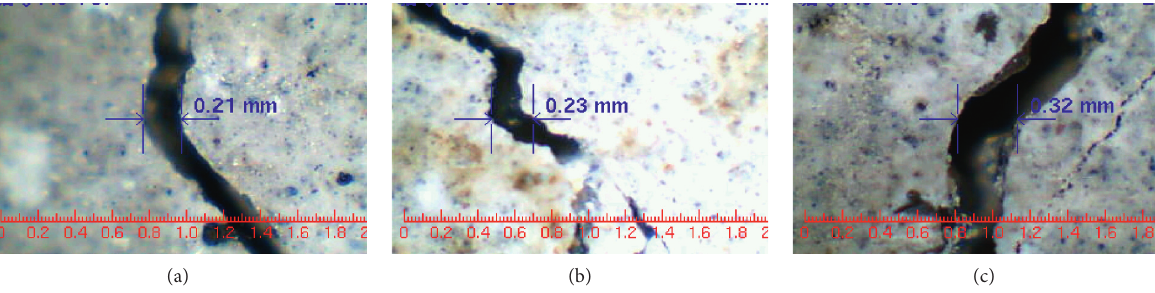
Figure 19: The largest crack in the concrete slab of PLG-2. (a) 200kN. (b) After 200,000 cycles. (c) After 1.5 million